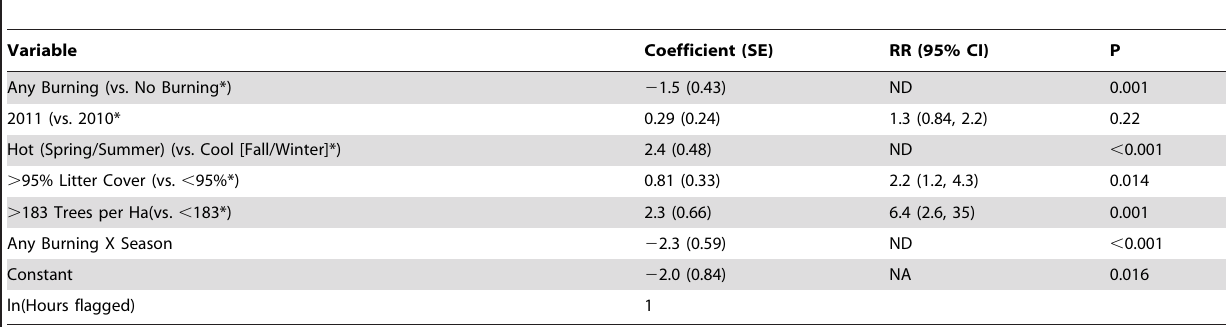
Table 3. Generalized estimating equation negative binomial regression model for the prediction of total tick counts at all 21 plots in 2010 and